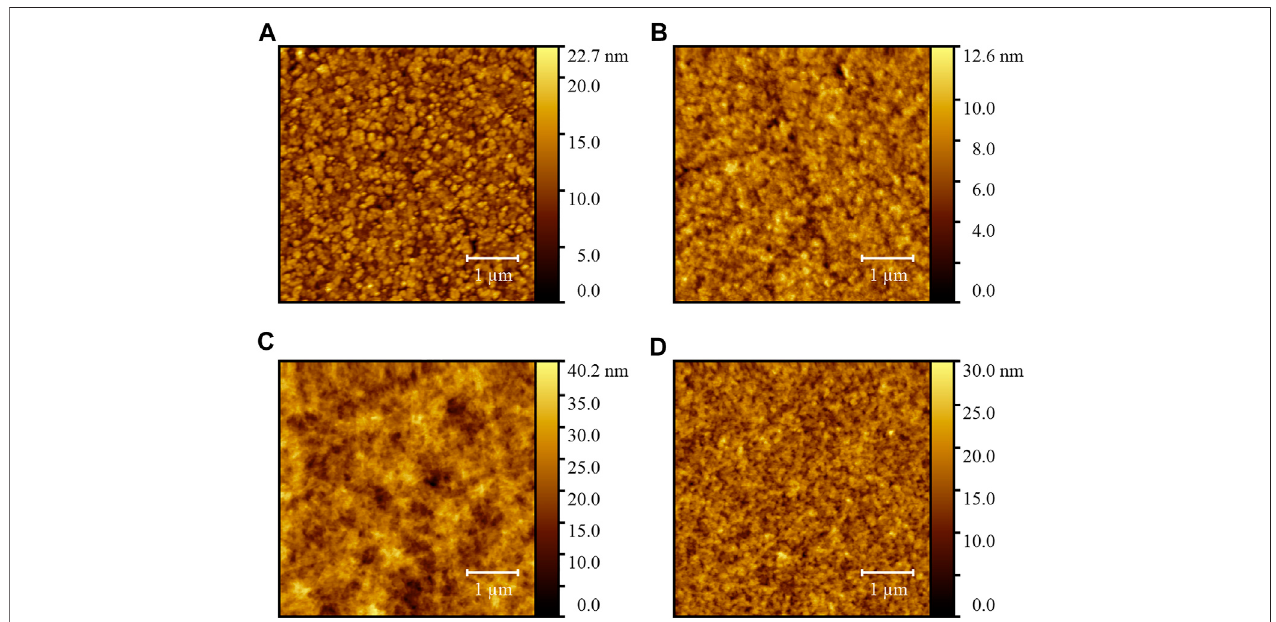
FIGURE 3 | (A) AFM height image of the SnO 2 ETL fi lm. (B) AFM height image of the SnO 2 /PDINO ETL fi lm. (C) AFM height image of the PM6:Y6 blend fi lm on the SnO